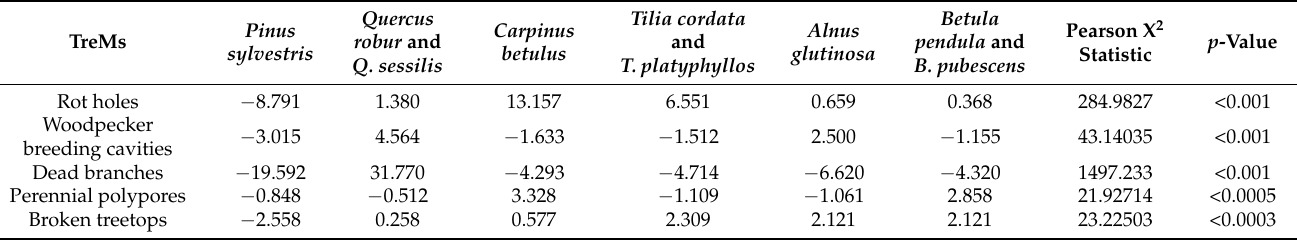
Table 3. Pearson chi-square test residuals for dependence of TreMs on individual tree